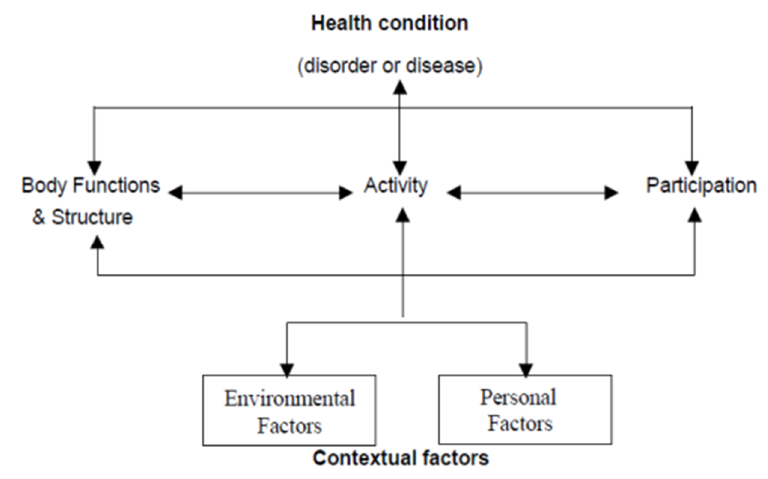
Figure 1. International Classification of Functioning—Paradigm of Overall Health.